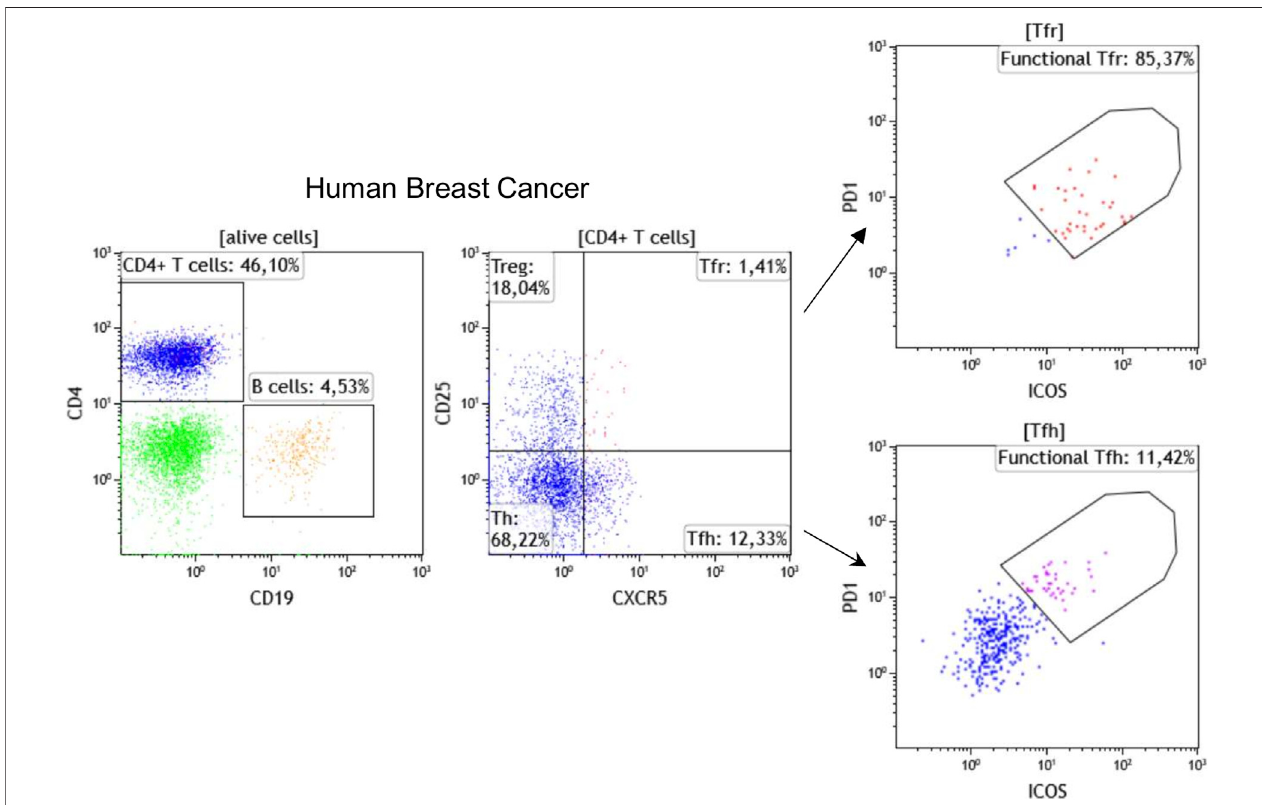
FIGURE1| ImmunophenotypingofT FH andT FR cellsby fl owcytometryusingfreshbreastcancertissues.RepresentativedotplotsshowthepercentageofCD19 + B cells, CD4 + T cells, CD25 − CXCR5 − CD4 + helper T cells (Th), CD25 + CXCR5 − CD4 + regulatory T (Treg), CD25 + CXCR5 + CD4 + T FR , and CD25 − CXCR5 + CD4 + T FH cells. The functionality of T FH and T FR cells has been demonstrated to be linked with PD-1 and ICOS expression